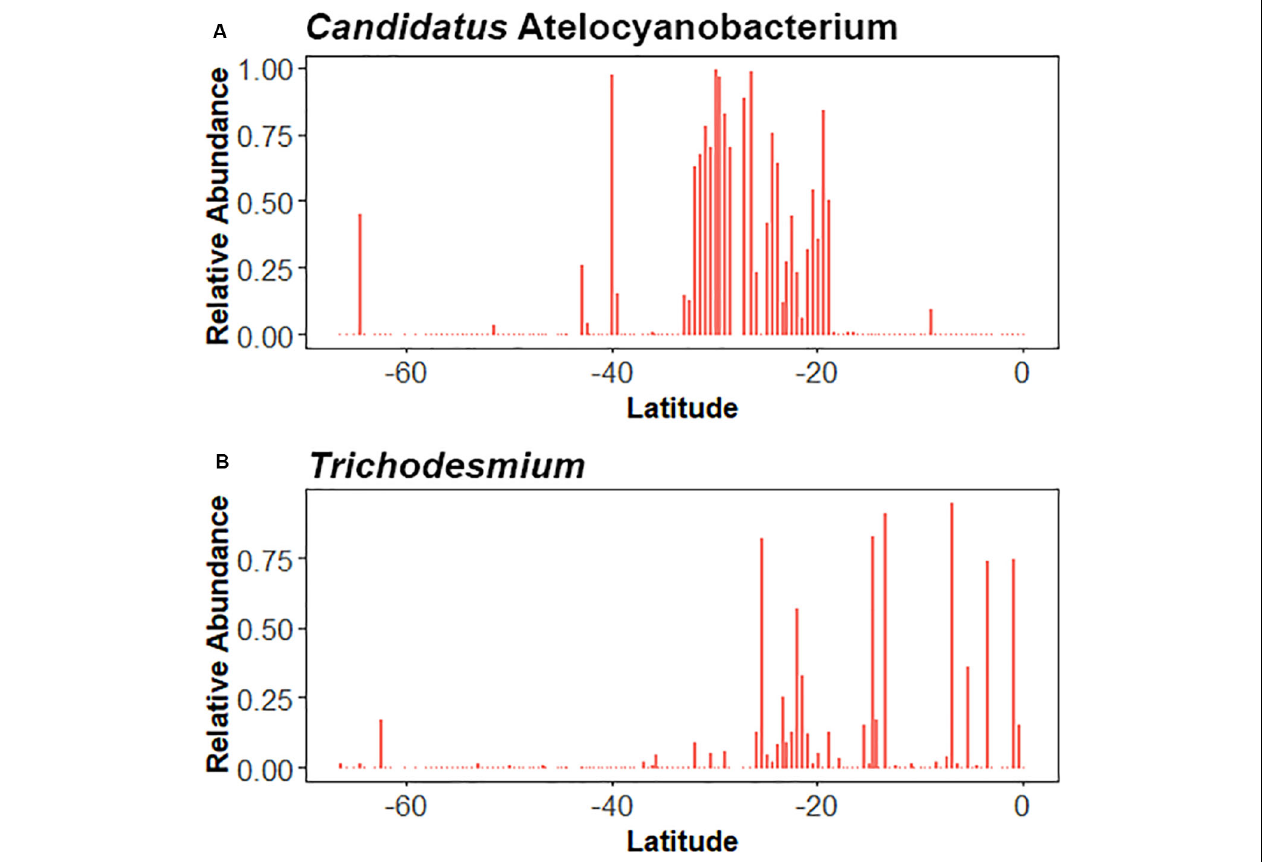
FIGURE 5 | Relative abundances for Candidatus Atelocyanobacterium (A) and Trichodesmium (B) along a latitudinal transect in the South Pacific Ocean.